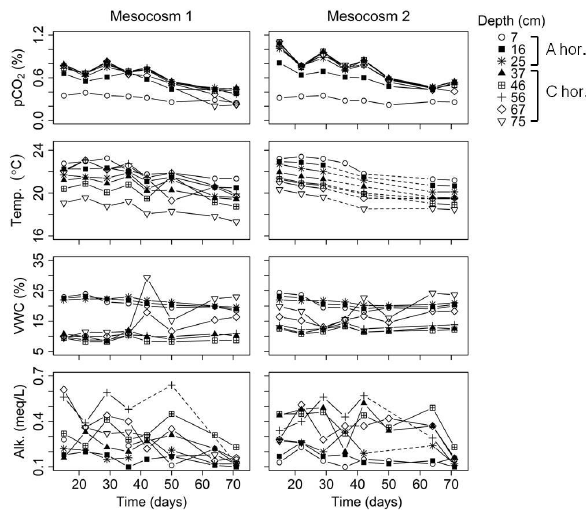
Fig. 3. Time course of linearly-interpolated p CO 2 , temperature, volumetric water content (VWC) and alkalinity on measurement days throughout depth in the mesocosms. Dashed lines indicate missing samples/measurements.